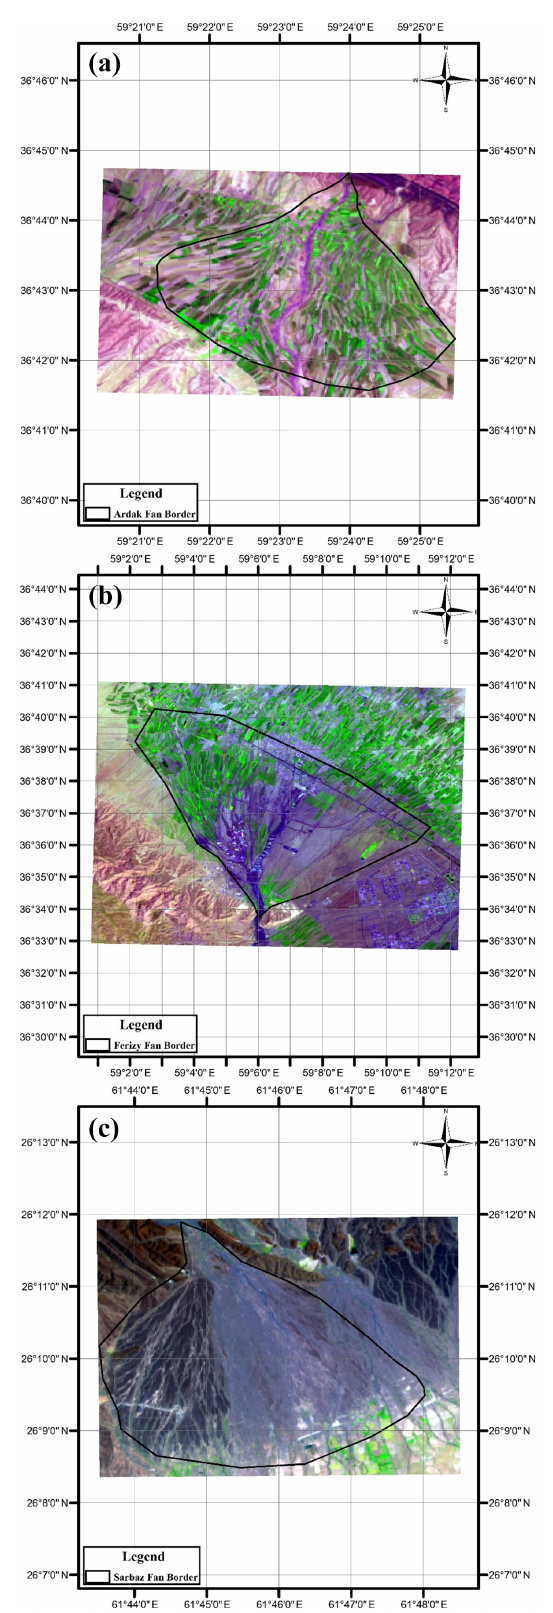
Figure 6. Aerial images of the (a) Ardak, (b) Ferizy, and (c) Sarbaz fans.